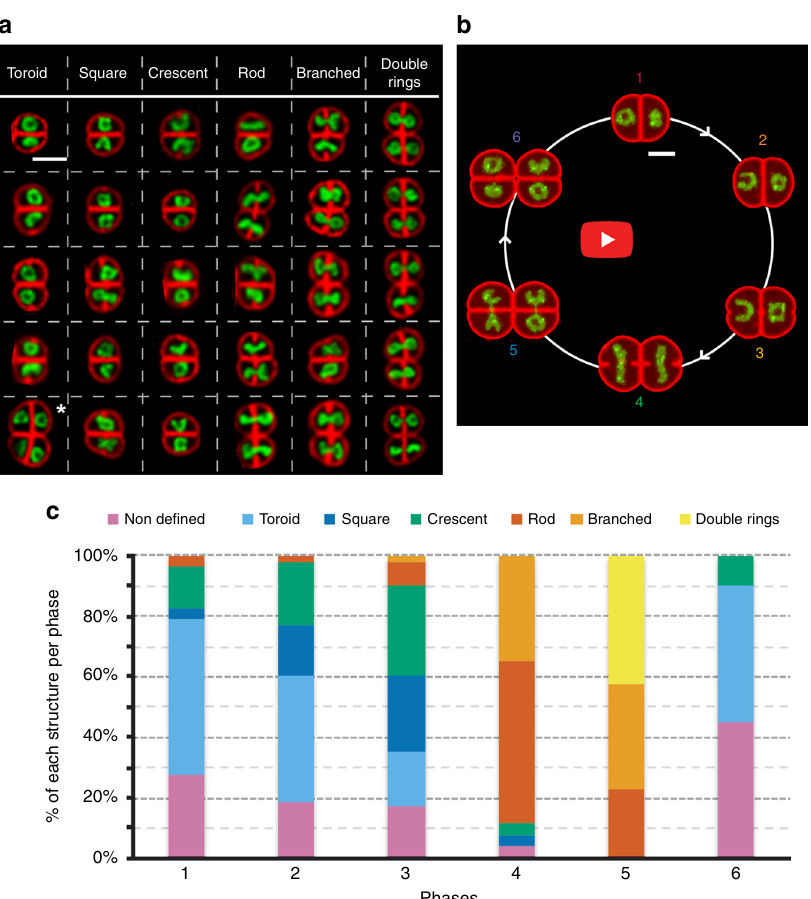
Fig. 3 Nucleoid organization in exponentially growing D. radiodurans . a Array of the representative shapes of D. radiodurans nucleoids stained with the DNA dye Syto9. Cell membranes were stained with Nile Red. In each box, the representative shape is seen in the upper cell of the diad. In the case of tetrads, the representative shape is the cell marked with an asterisk. Scale: 2 µ m. b Snapshot of the on-scale simulated reconstitution of the changes in cell shape and nucleoid structure occurring during the D. radiodurans cell cycle, illustrating the tight coordination of nucleoid rearrangements with septal growth (Supplementary Movie 4). Scale bar: 1 µ m. c Distribution of the various nucleoid morphologies observed as a function of the phases of the cell cycle ( N = 232 nucleoids; N > 26 for each phase). Source data are provided as a Source Data fi